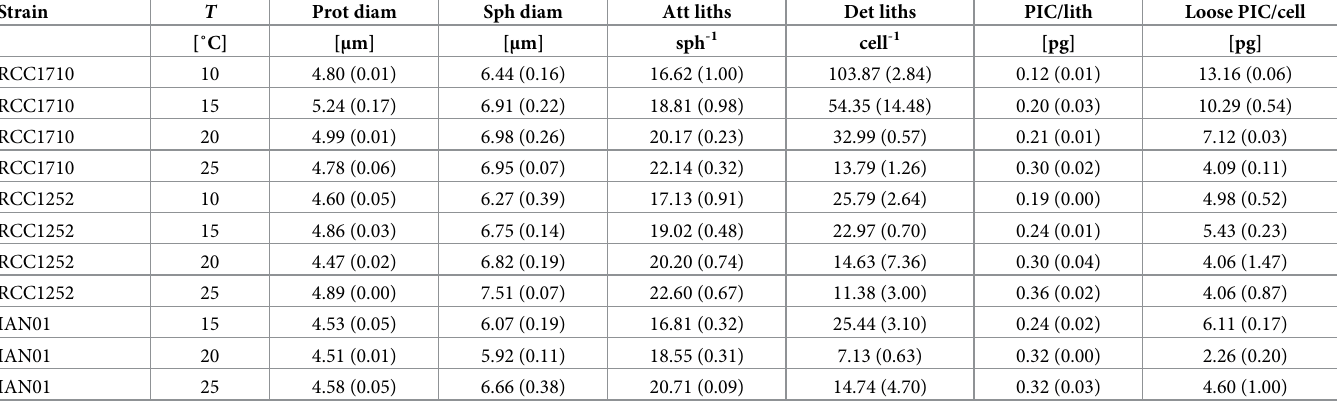
Table 2. Protoplast and coccosphere diameter, number of attached and detached coccoliths per cell, particulate inorganic carbon (PIC) per coccolith, and loose PIC per